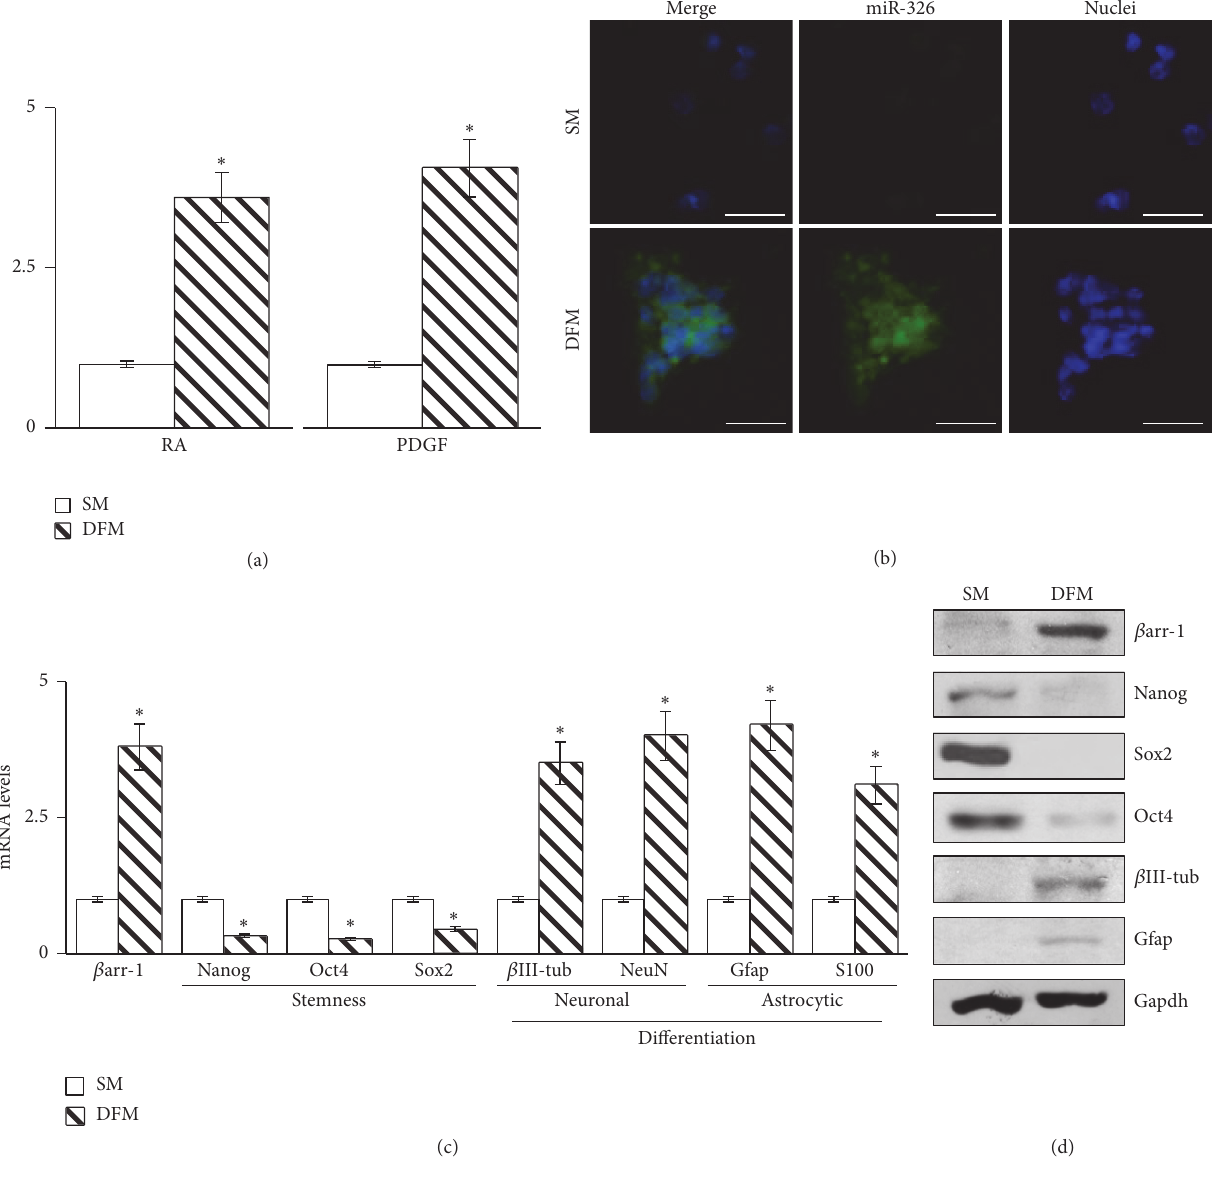
Figure 2: miR-326 and 𝛽 arr-1 are upregulated in differentiated NSCs. (a) miR-326 levels evaluated in NSC exposed to differentiation stimuli (DFM) with retinoic acid (RA) or platelet-derived growth factor (PDGF) for 48 hours. Data are means ± SD from 3 independent experiments. ∗ 𝑝 < 0.05 . (b) Fluorescent in situ hybridization (ISH) staining of miR-326 of NSCs grown in stemness conditions (SM) and after RA-induced differentiation (DFM) for 48 hours. Nuclei are counterstained with Hoechst. Scale bar: 10 𝜇 m. Representative ISH images from 4 independent experiments. (c) mRNA expression levels of 𝛽 arr-1 along with stemness and differentiation markers of NSC in SM and after differentiation (DFM). (d) Western blot (WB) analysis of endogenous 𝛽 arr-1 and markers of stemness (Nanog, Sox2, and Oct4) and differentiation ( 𝛽 III- tub and Gfap) of NSCs in SM and after differentiation (DFM). Gapdh as loading control (LC). ((c) and (d)) Data are means ± SD from 3 independent experiments. ∗ 𝑝 < 0.05